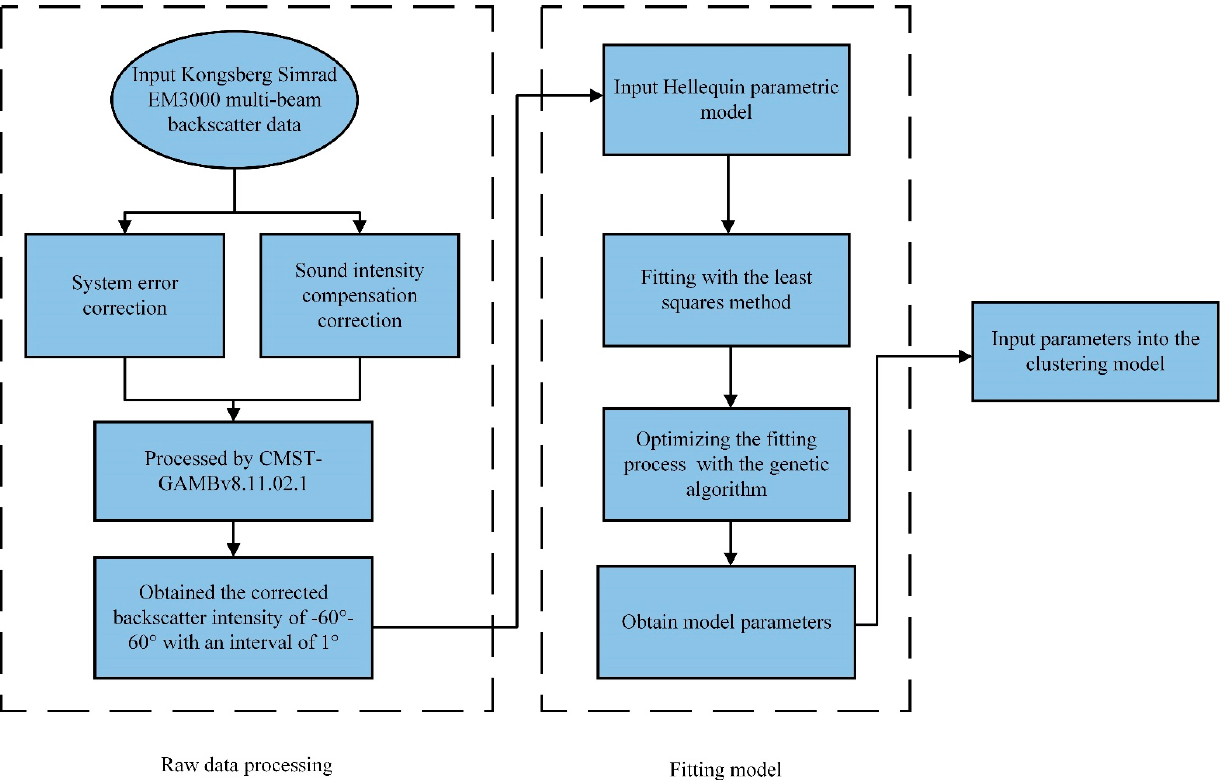
Figure 1. Sketch of the experiment process.